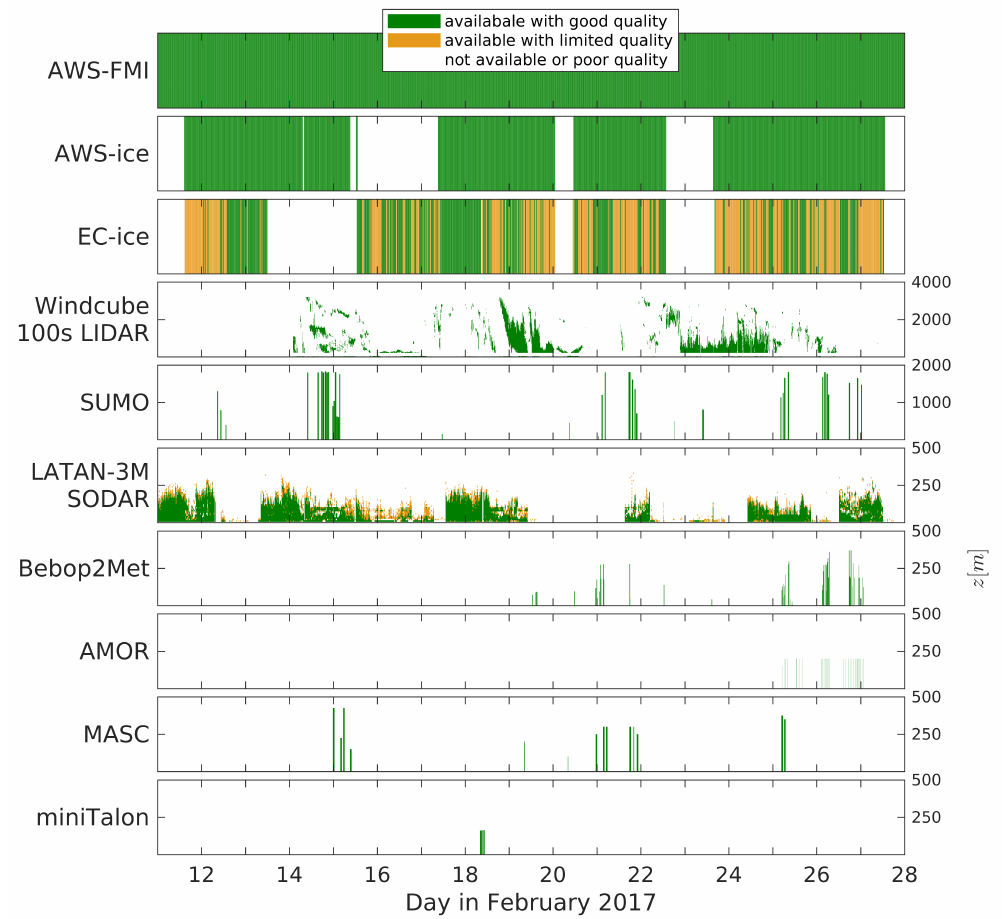
Figure 4. Data availability and corresponding altitude (only for profiling systems) for the different observation systems during the campaign period. Green indicates the availability of good quality data where applicable; orange corresponds to available data of limited quality; and the white gaps indicate poor quality or missing